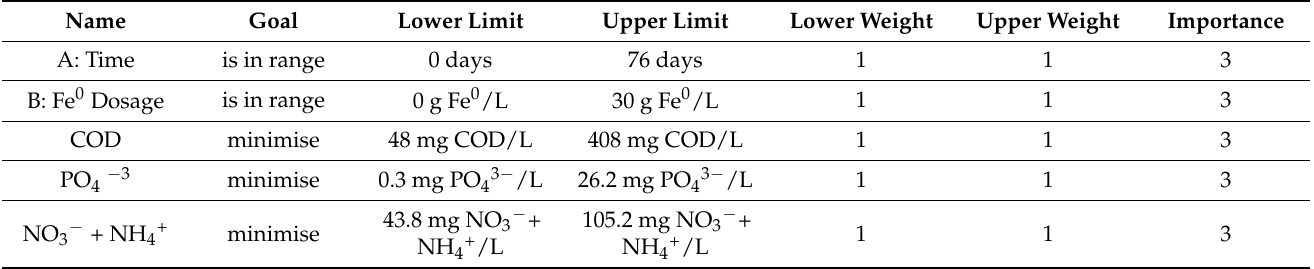
Table 4. Set of constraints for optimisation of the objective function.